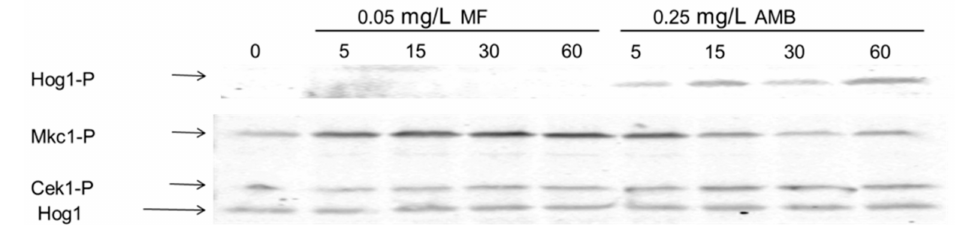
Figure 6. Role of the Mitogen-Activated Protein kinase (MAPK) pathways in the response to MF and AMB. Wild-type cells were challenged with MF or AMB at 37 ◦ C in YPD liquid medium. Then, samples were collected at di ff erent time points (indicated in min) and processed for immunoblotting. The Hog1 phosphorylated form was detected using anti-phospho-p38 antibody (Hog1-P), and phosphorylated Mkc1 (Mkc1-P) and Cek1 (Cek1-P) forms were detected using anti-phospho-p42-44 antibody. Total Hog1 protein was detected with an anti-ScHog1 antibody and used as the load